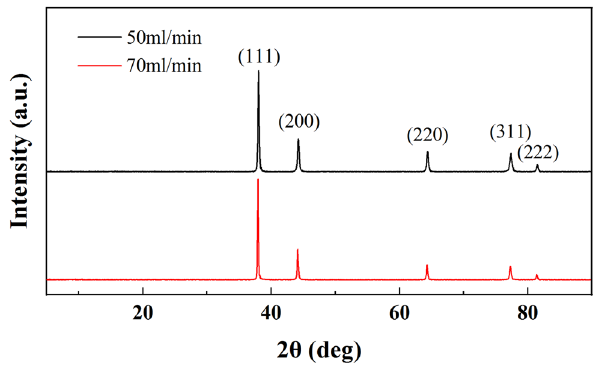
Figure 3: XRD of the fl ake silver powders prepared at di ff erent fl ow rates ( 50 and 70 mL · min − 1 ) .